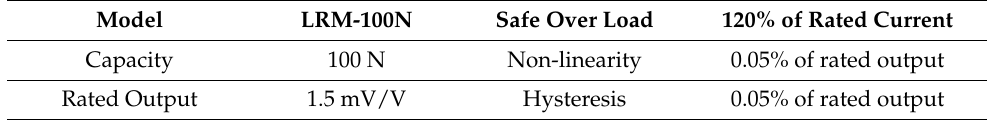
Table 3. Specifications of load cell used for measuring the actuating force.